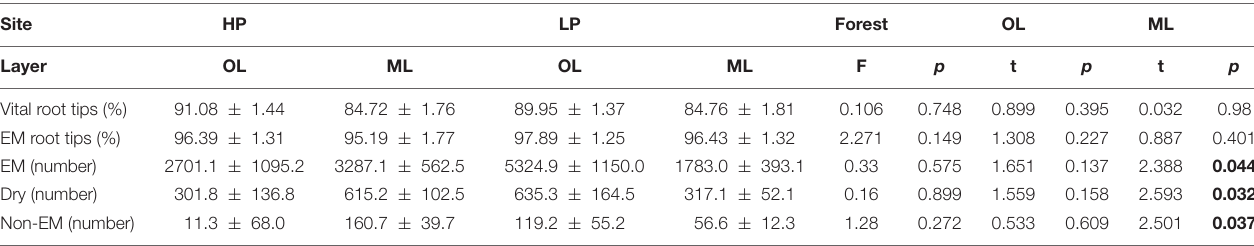
TABLE 2 | Vitality, ectomycorrhizal (EM) colonization and number of beech root tips (soil core − 1 ) in the organic layer (OL) and mineral topsoil (ML) from a P-rich (HP) and P-poor beech ( Fagus sylvatica ) forest. Site HP LP Forest OL ML